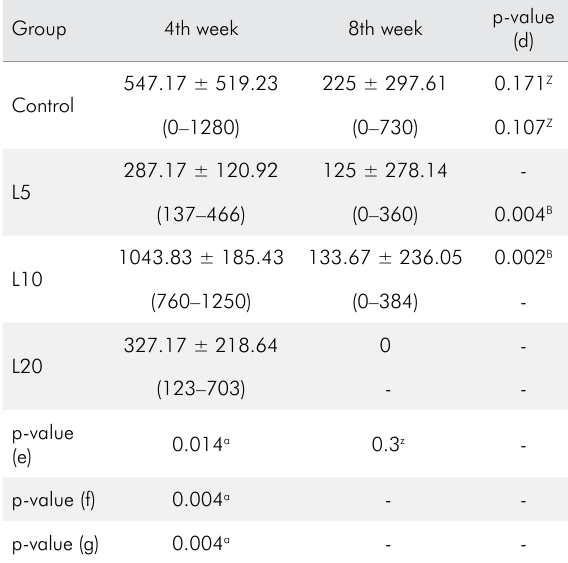
Table 4. Analysis of fibroblast number among groups and dependent on time; Data presented as mean ± standard deviation (minimum–maximum).